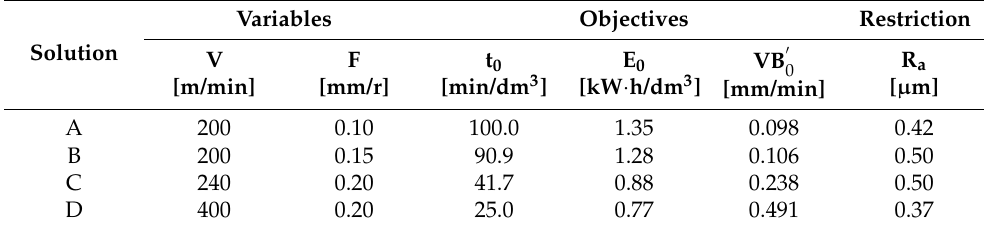
Table 5. Relevant solutions for MQL machining.